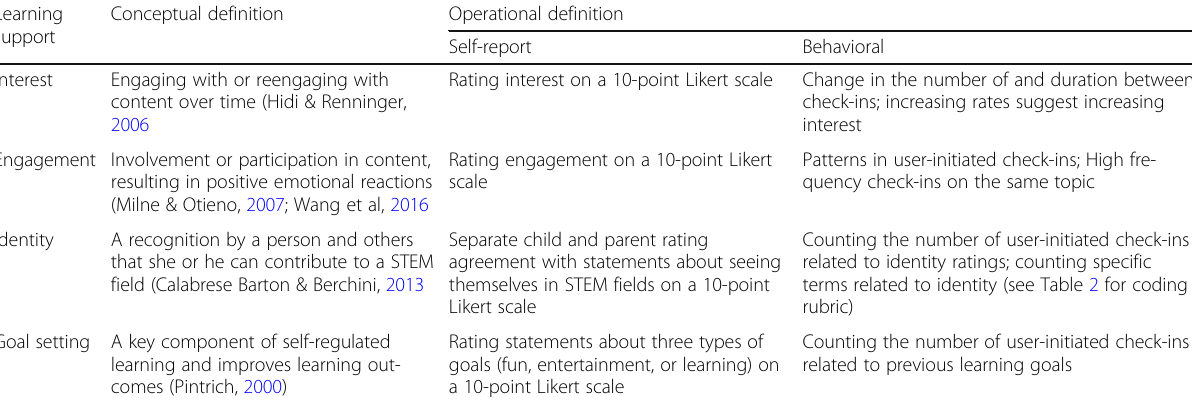
Table 1 STEM learning supports: conceptual and operational definitions Learning